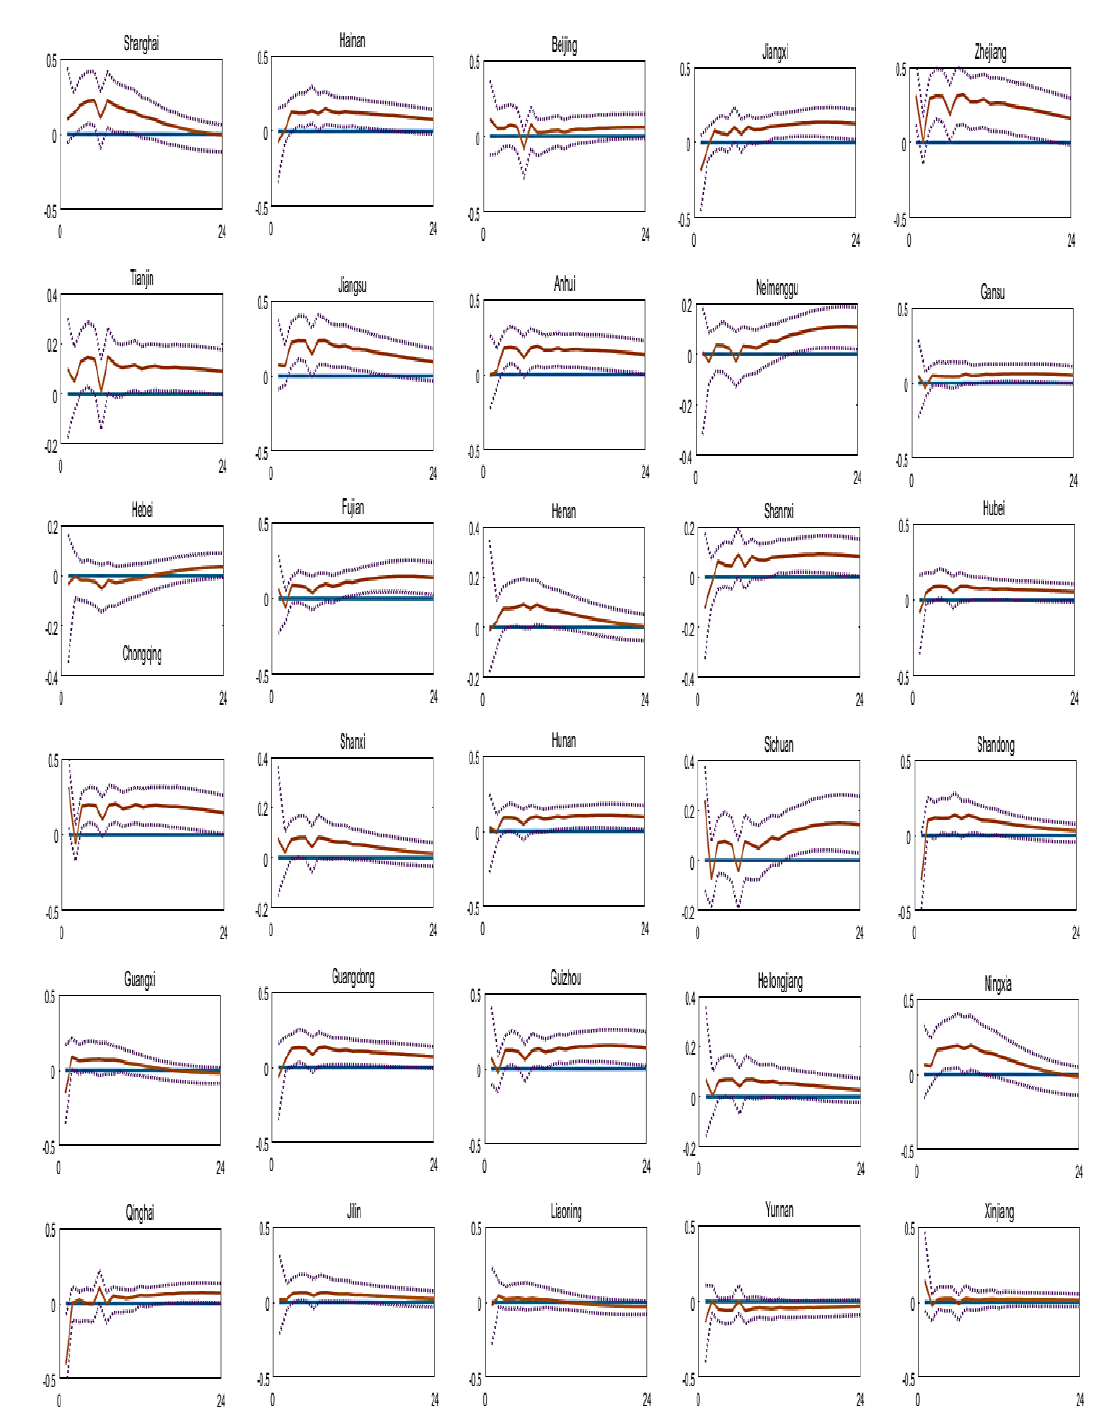
Figure 4. Impulse responses of regional house prices to one standard error shock to real output: FAVAR system with one factor.